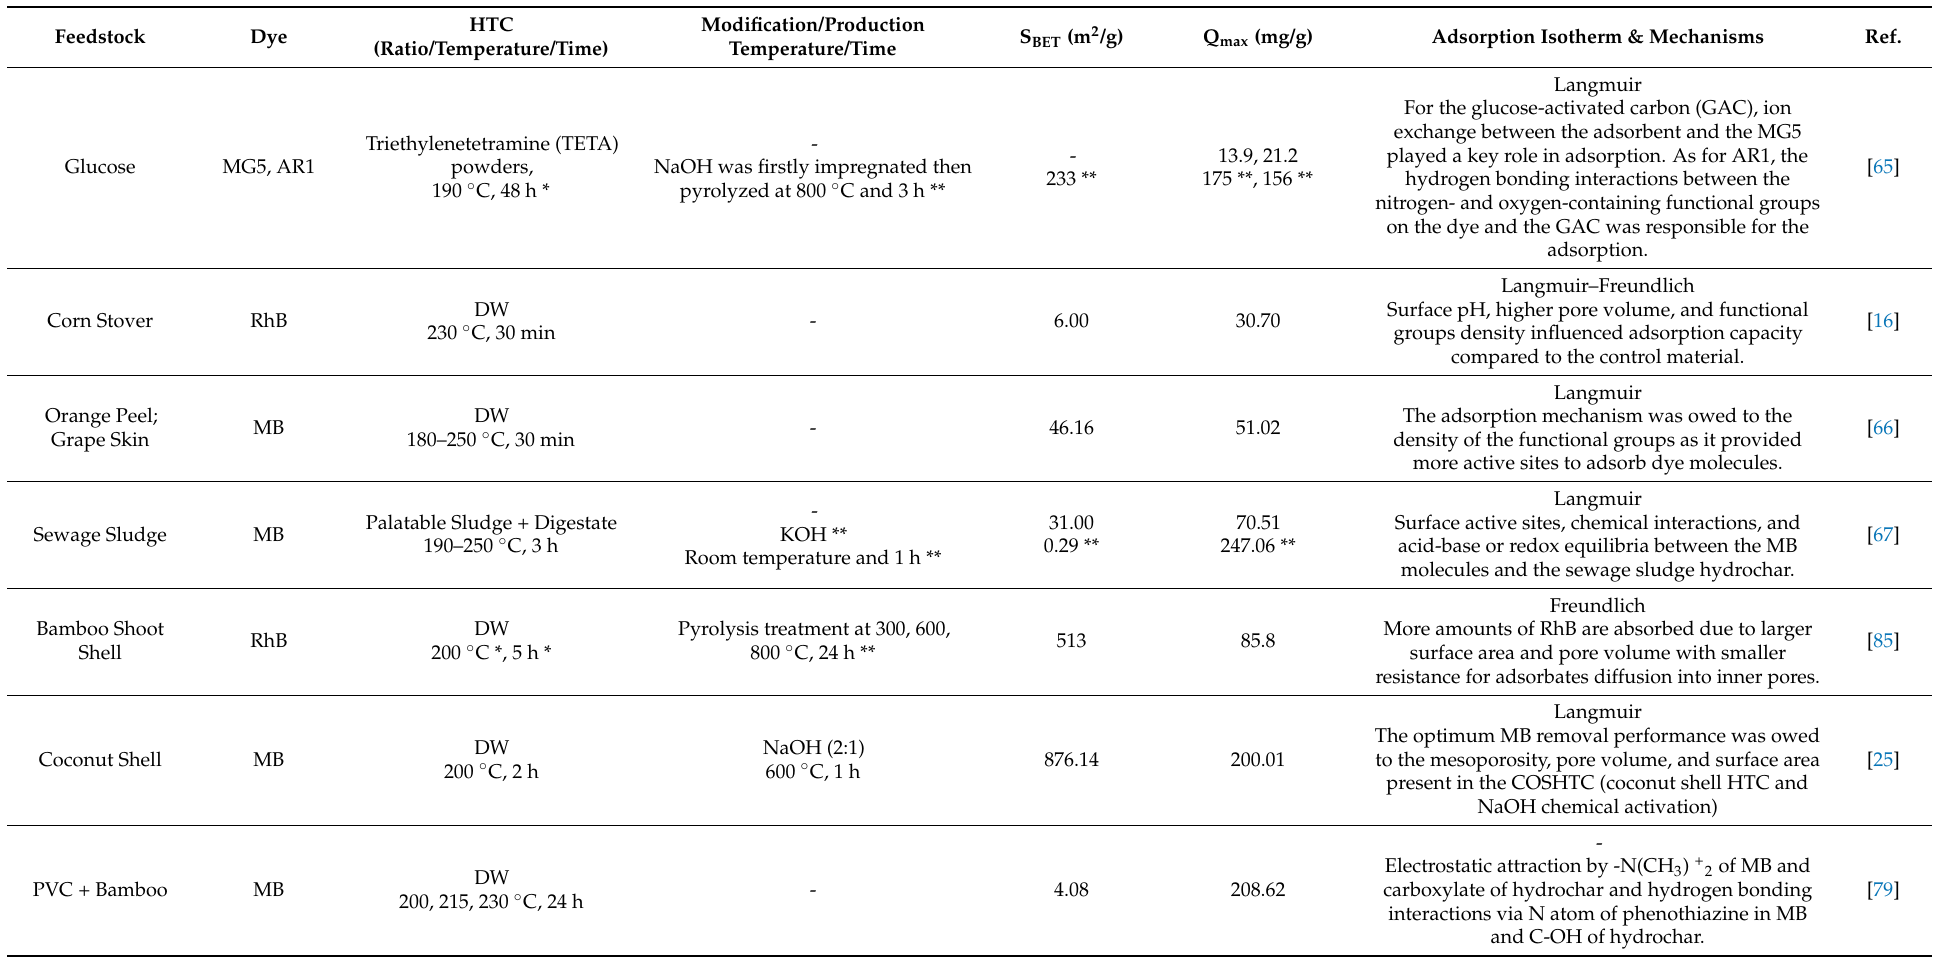
Table 2. Dye adsorption by hydrochars and activated